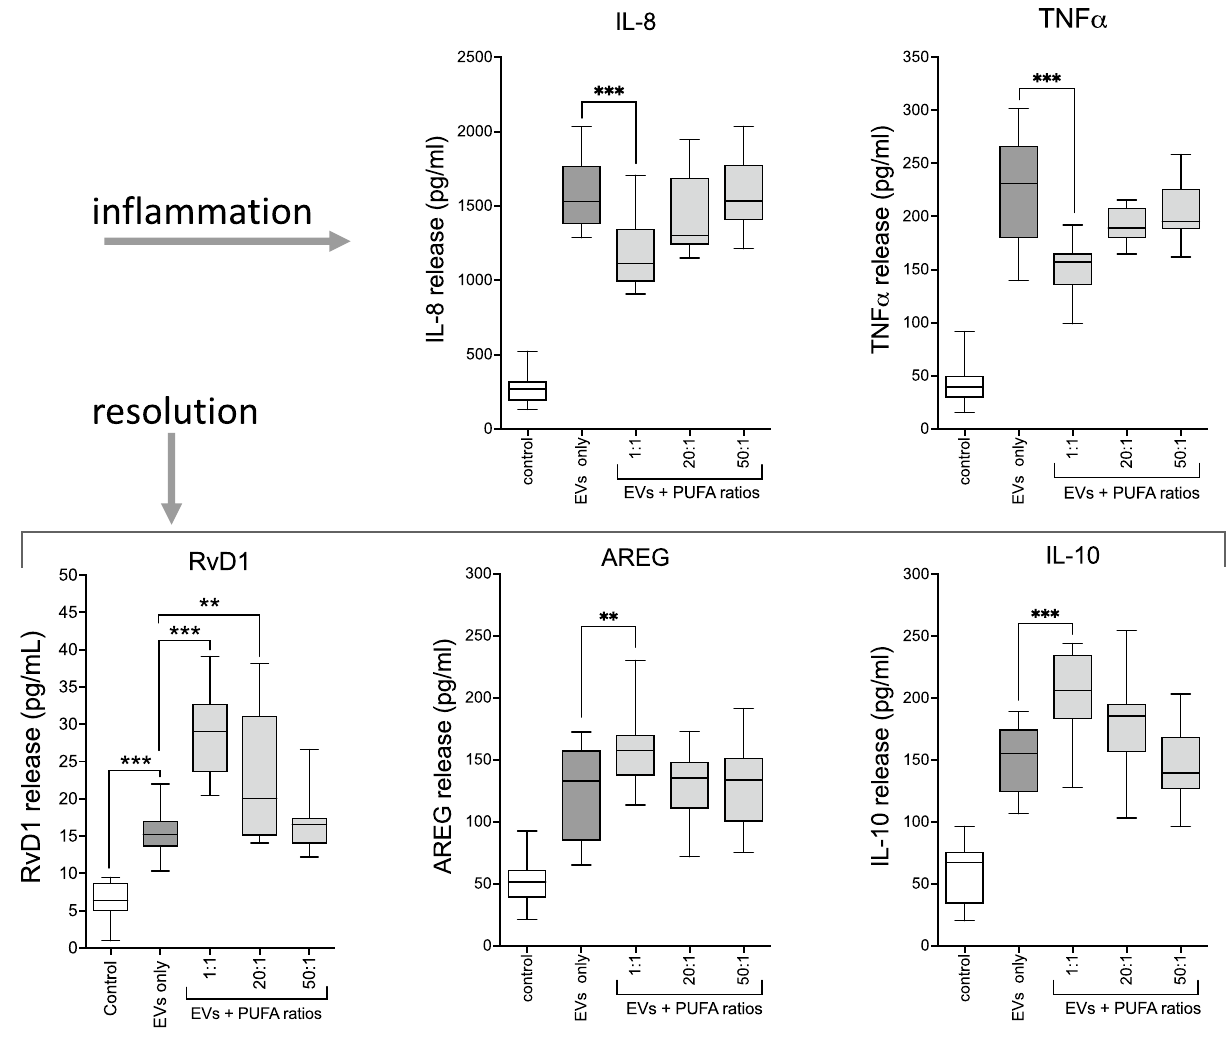
Figure 8. The DHA-rich PUFA ratio (1:1) inhibited EV-mediated proinflammatory cytokine release but augmented pro-repair mediator release from MDM during recovery. Sub-confluent monocyte-derived macrophages were challenged with EVs for 2 h, then allowed to recover in the presence of PUFA ratios for 22 h. The DHA-rich ratio dampened the EV-induced release of inflammatory cytokines (IL-8, TNFα) and elevated the release of pro-repair mediators RvD1, AREG, IL-10. Data pooled from n = 5 experiments, 24 technical replicates. **p < 0.01, ***p < 0.0001, for indicated comparisons (ANOVA, Tukey’s post-hoc